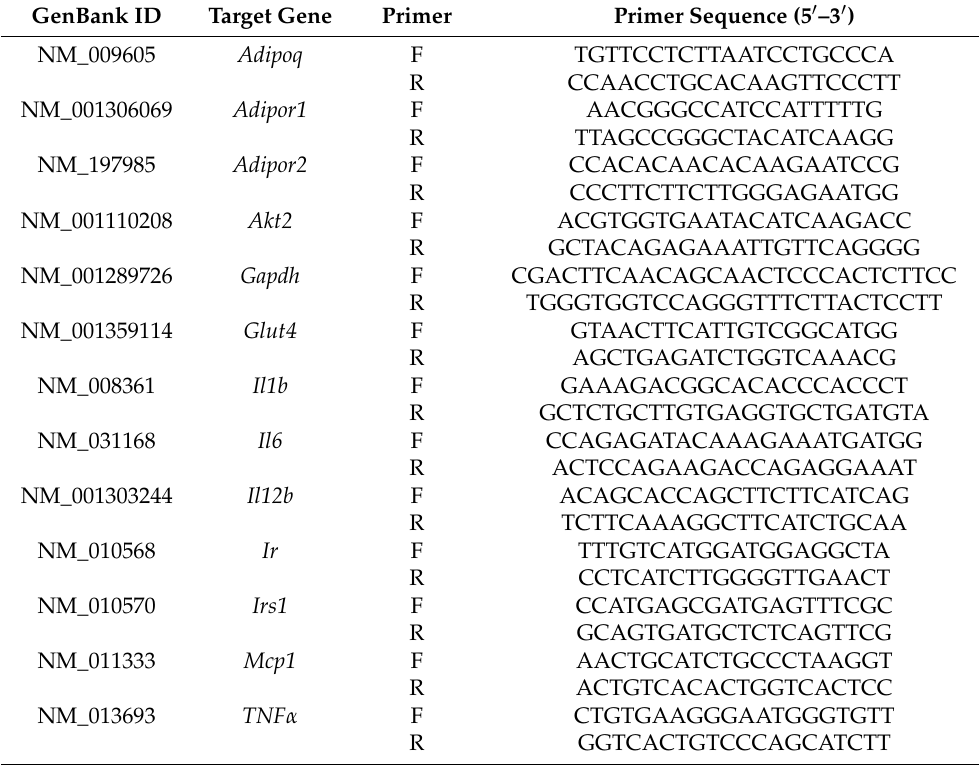
Table 1. Primer pairs used for the quantitative RT-PCR analysis. GenBank